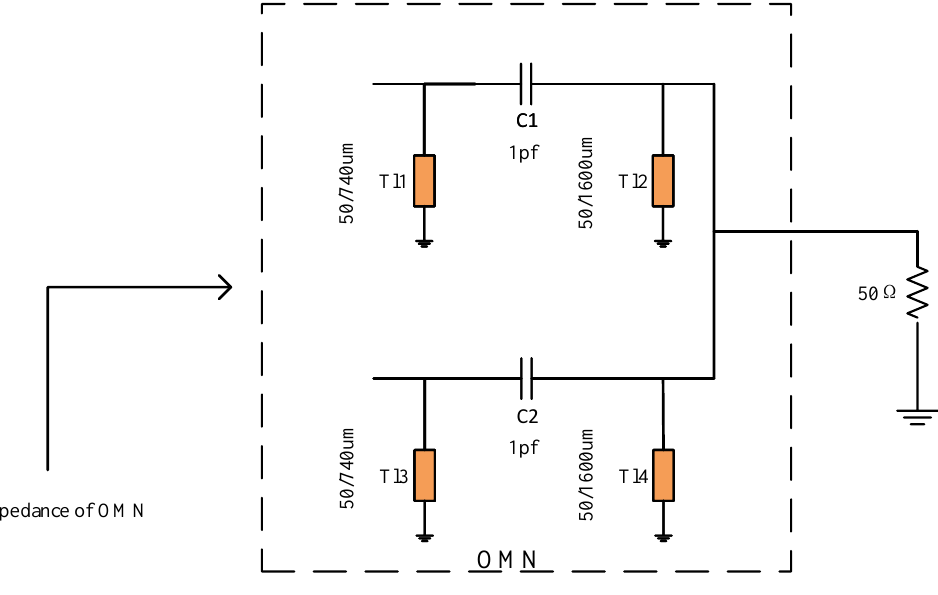
Figure 7. Circuit structure of the proposed OMN. The structure of the OMN is simple; the insertion loss is reduced as much as possible on the premise of satisfying conjugate matching. The insertion loss and return loss of the OMN are shown in Figure 8a. It is seen that the loss of the output matching circuit is 1.3–0.6 dB across the frequency range of 7–13 GHz, with a return loss of better than 12 dB, which means the developed amplifier has a high efficiency and high P out performance. Figure 8b demonstrates the matching effect reflected by the output matching network. It can be seen that the points of actual load impedance are basically located in the optimum impedance region throughout a frequency from 7 to 13 GHz, that mean a good output matching is